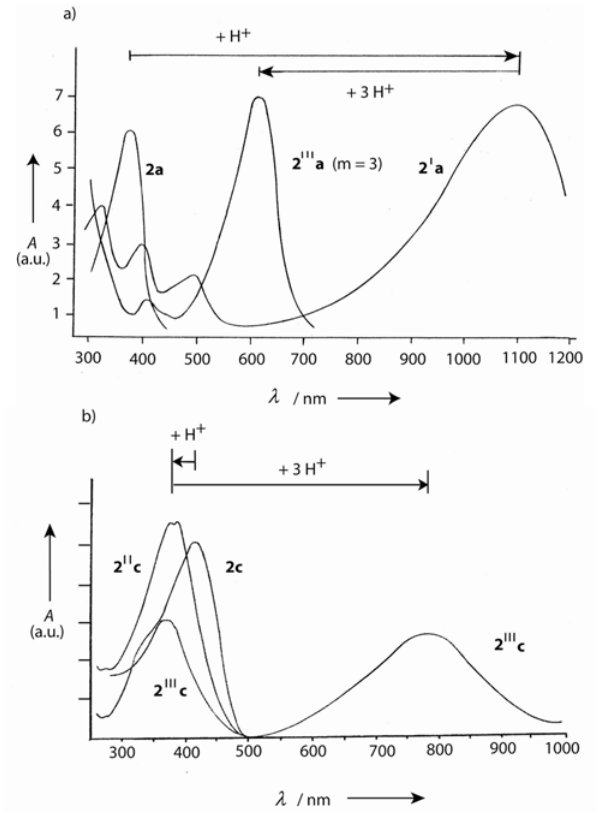
Figure 7. ( a) UV/Vis/NIR absorption of 7a in CHCl , with 7  a as the major component 3 obtained by primary protonation and 7  a obtained as the major component in the final protonation (CHCl /CF COOH). (b) UV/Vis/NIR absorption of 7  c in CHCl , N -protonated 3 3 3 carbinol 7  c , and methylium salt 7  c as major component after the final protonation with COOH (molar ratio 7c /CF COOH, 1:200) CF 3 3